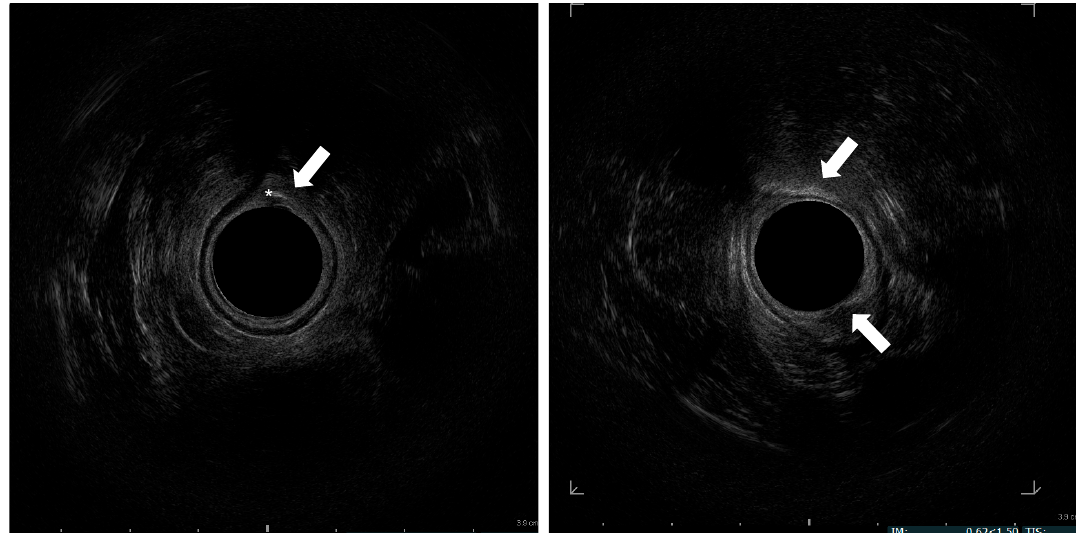
Figure 2. Endosonographic axial sections of the middle anal canal. Asterisk: needle in the internal anal sphincter; Arrow: injected fat tissue h 6 and 12.